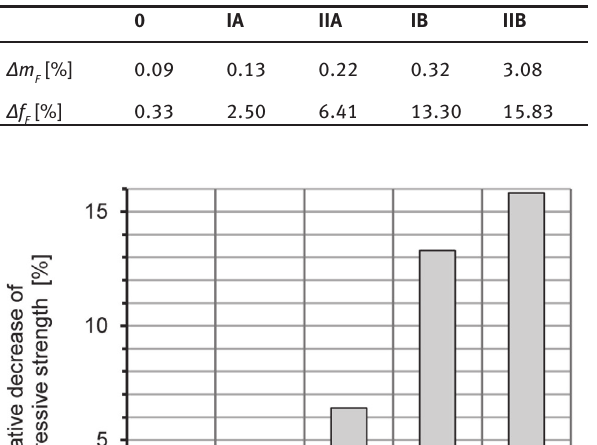
Table 6: Relative mass losses ∆m